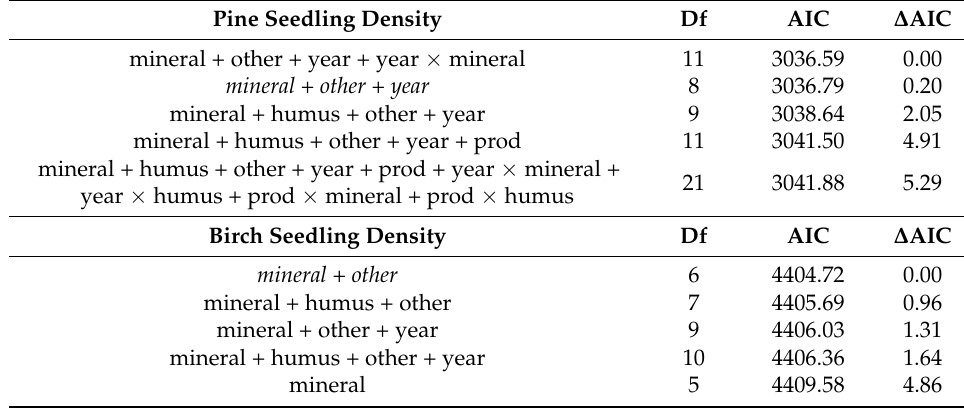
Table 4. Results from model selection on density of Scots pine and birch seedlings, measured as number of seedlings per sampling point. The table shows the five models with lowest AIC from 24 candidate models for pine and 17 candidate models for birch. Model parameters are presented with corresponding degrees of freedom (Df), AIC value, ∆ AIC, and AIC weights. Models are ranked from lowest to highest AIC. The models which were considered the most optimal are written in italics. Abbreviated variable names are: mineral = proportion of exposed mineral soil, humus = proportion of exposed humus, year = year of scarification, other = proportion of other cover, prod = forest productivity index. Pine Seedling Density Df AIC ∆ AIC mineral + other + year + year × mineral